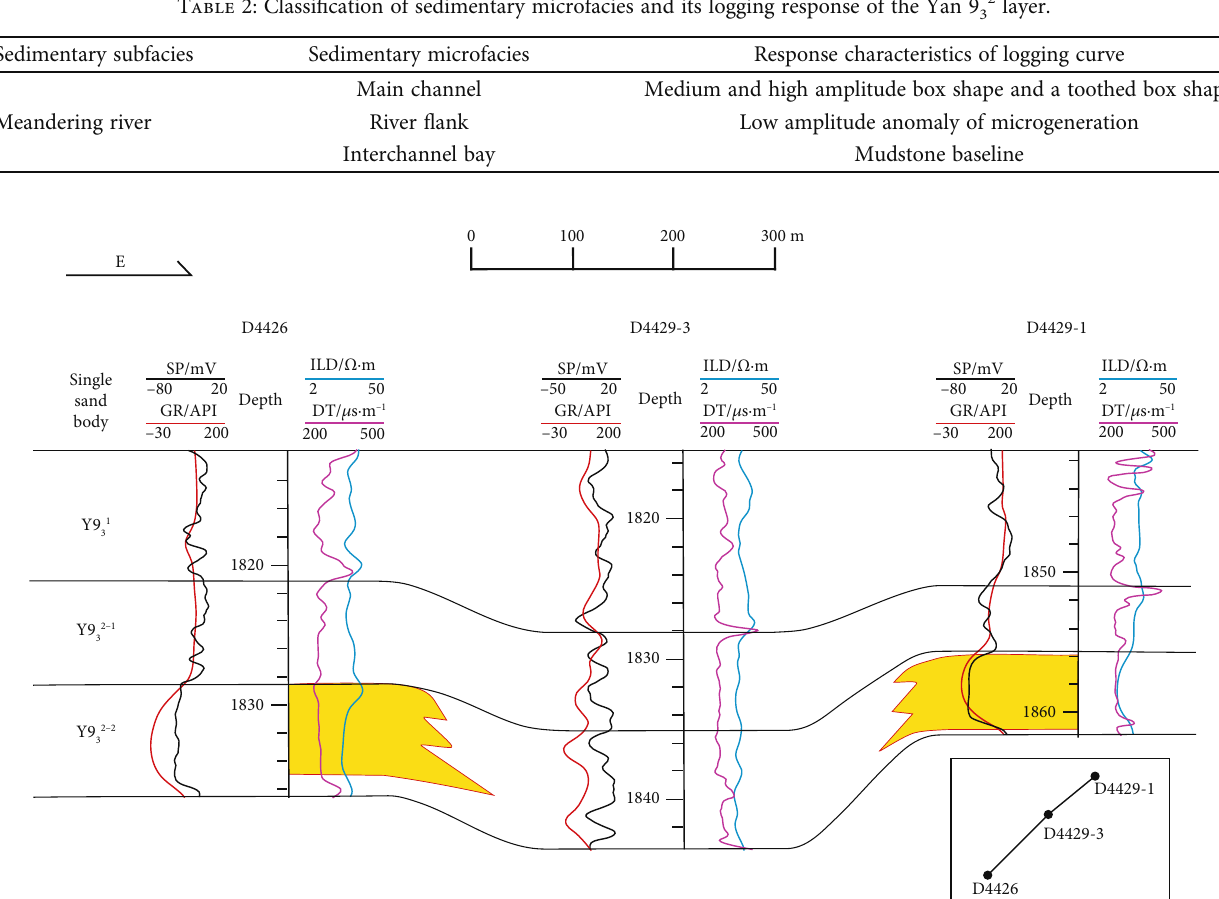
Figure 8: Schematic diagram of the argillaceous